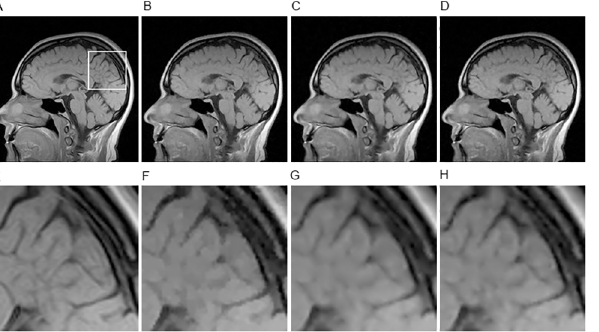
Fig 1. The reconstructed results of different methods on Brain image from noisy and undersampled Fourier data (noise level: 30 dB and sampling ratio: 20%). (A) Original image; (B) TV-FISTA result; (C) HDTV2-MM result; (D) HDTV2-FBS result; (E) the zoomed version of region marked by the white box in original image; (F) the zoomed version of TV-FISTA result; (G) the zoomed version of HDTV2-MM result; (H) the zoomed version of HDTV2-FBS